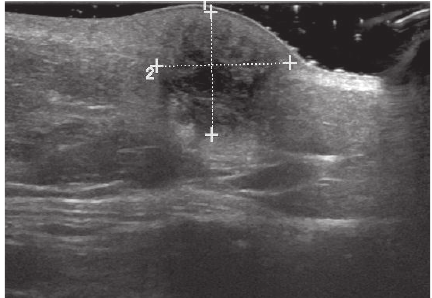
Figure 3: Ultrasonography image of the right breast showing 1.4cm × 1.2 cm irregularly shaped, speculated, hypoechoic lesion with central necrotic changes and high